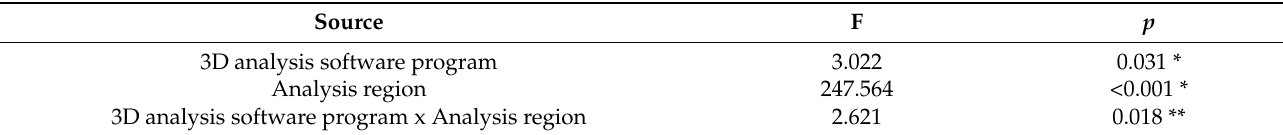
Table 4. Results of the ANOVA of the three-dimensional analysis software program and analysis region. Source F 3D analysis software